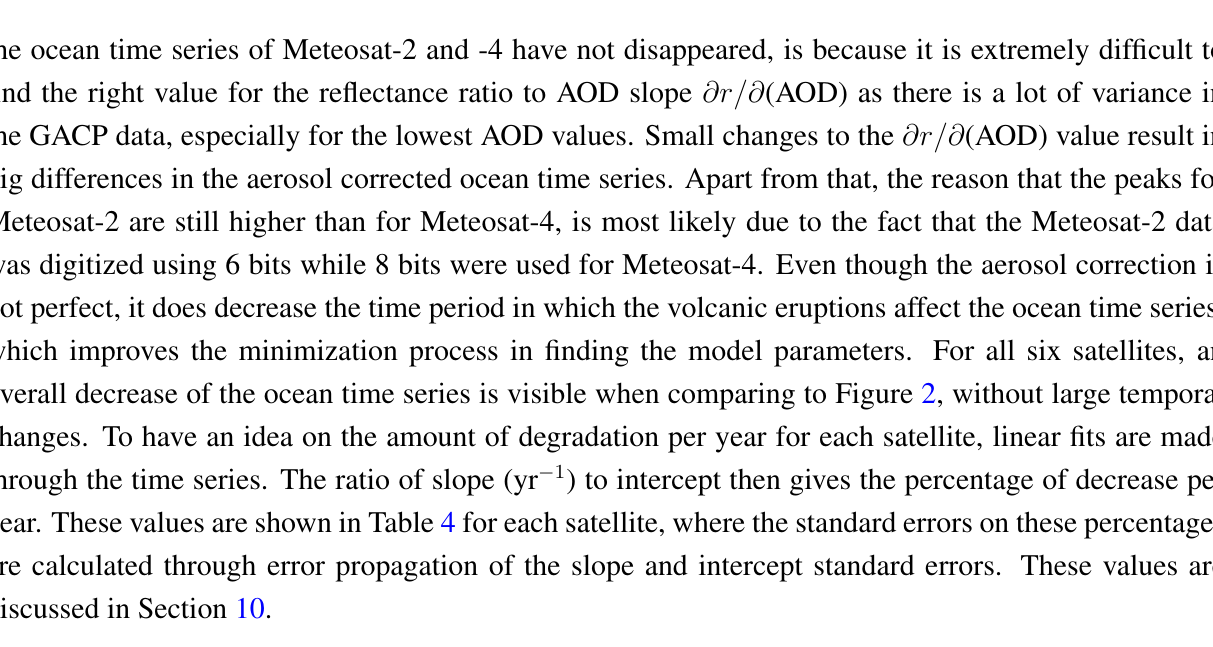
Figure 6. The seasonal corrected time series for all 6 satellites, where the ocean time series is also corrected for aerosols using the GACP AOD